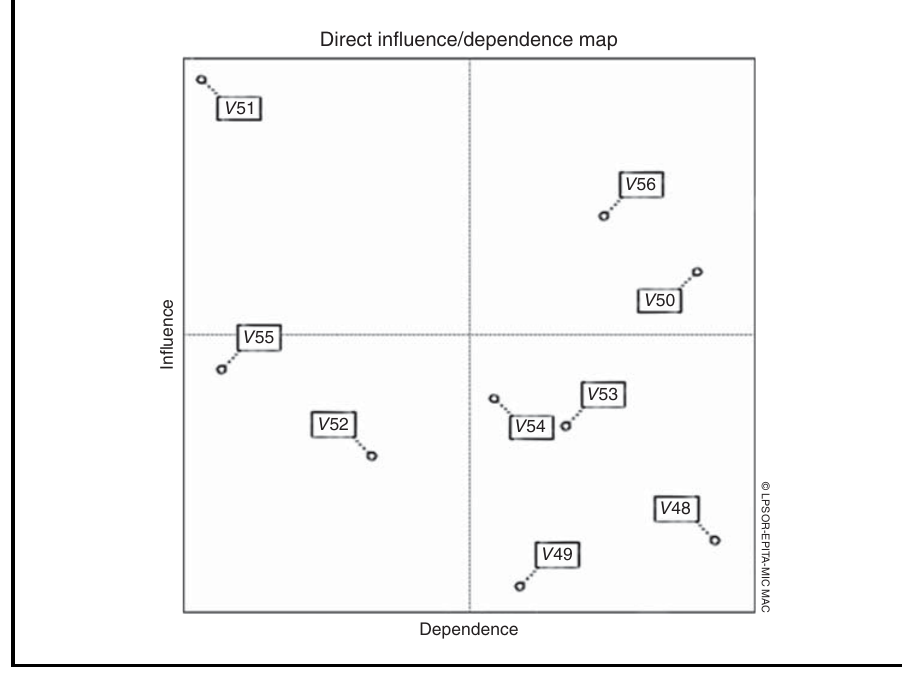
Figure 14 Environmental negative influence relations Direct influence